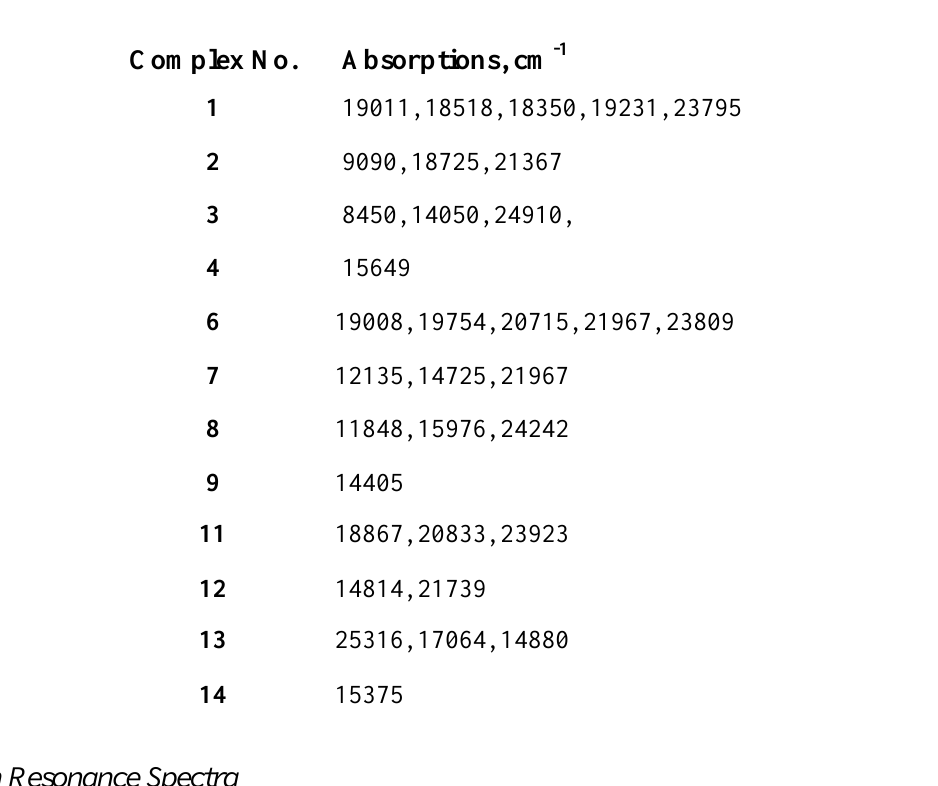
Table 2 : Electronic spectral data of transition metal complexes of ligands HN , HMPN and